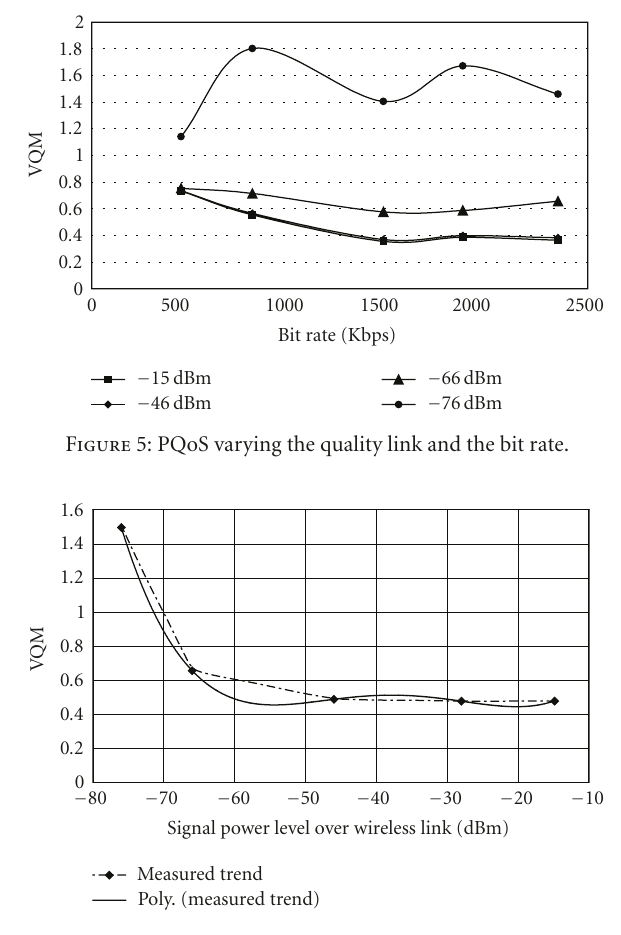
Figure 6: PQoS varying the link power